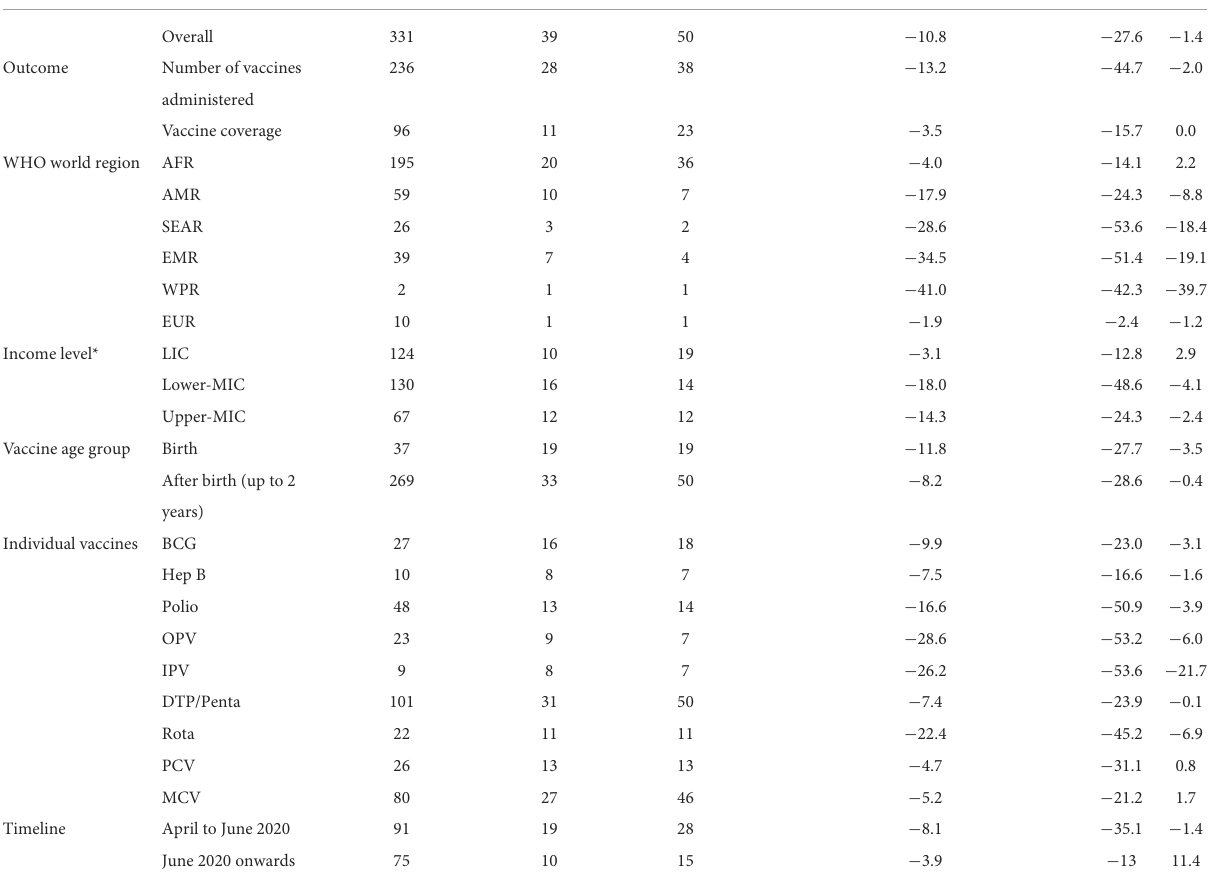
TABLE 2 Median change ( ± interquartile range) in level of vaccination.